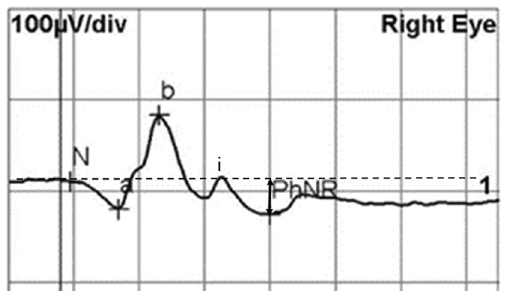
Figure 1. Representative electroretinogram by red stimulus on blue background. a-wave, b-wave, i-wave, and photopic negative response (PhNR) were indicated. The PhNR amplitude was determined from baseline to the negative trough of the negative peak at ~ 80 ms after b-wave and i-wave.